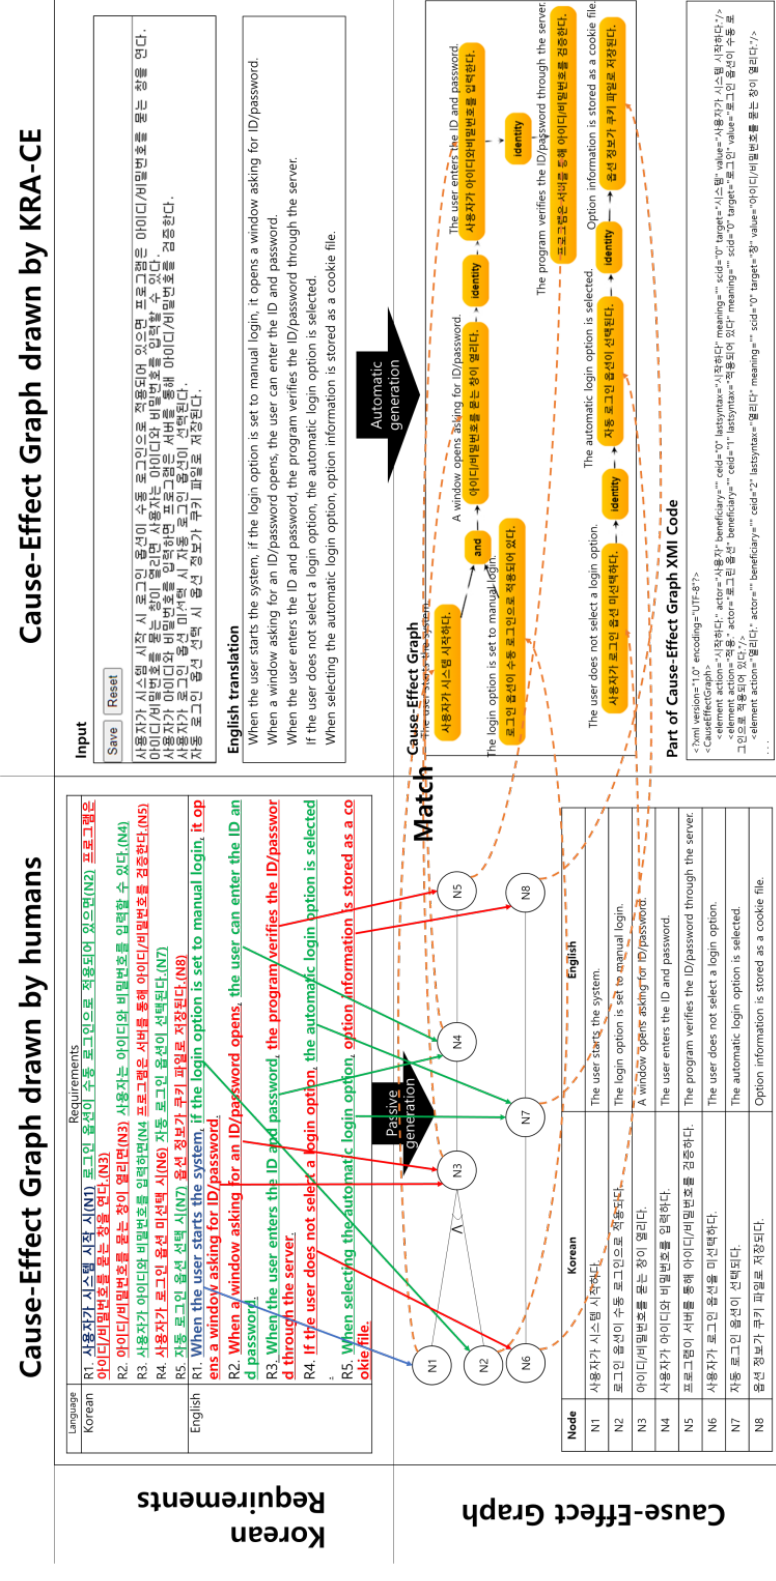
Figure 16. Comparison of cause – effect graph drawn by humans and KRA-CE.